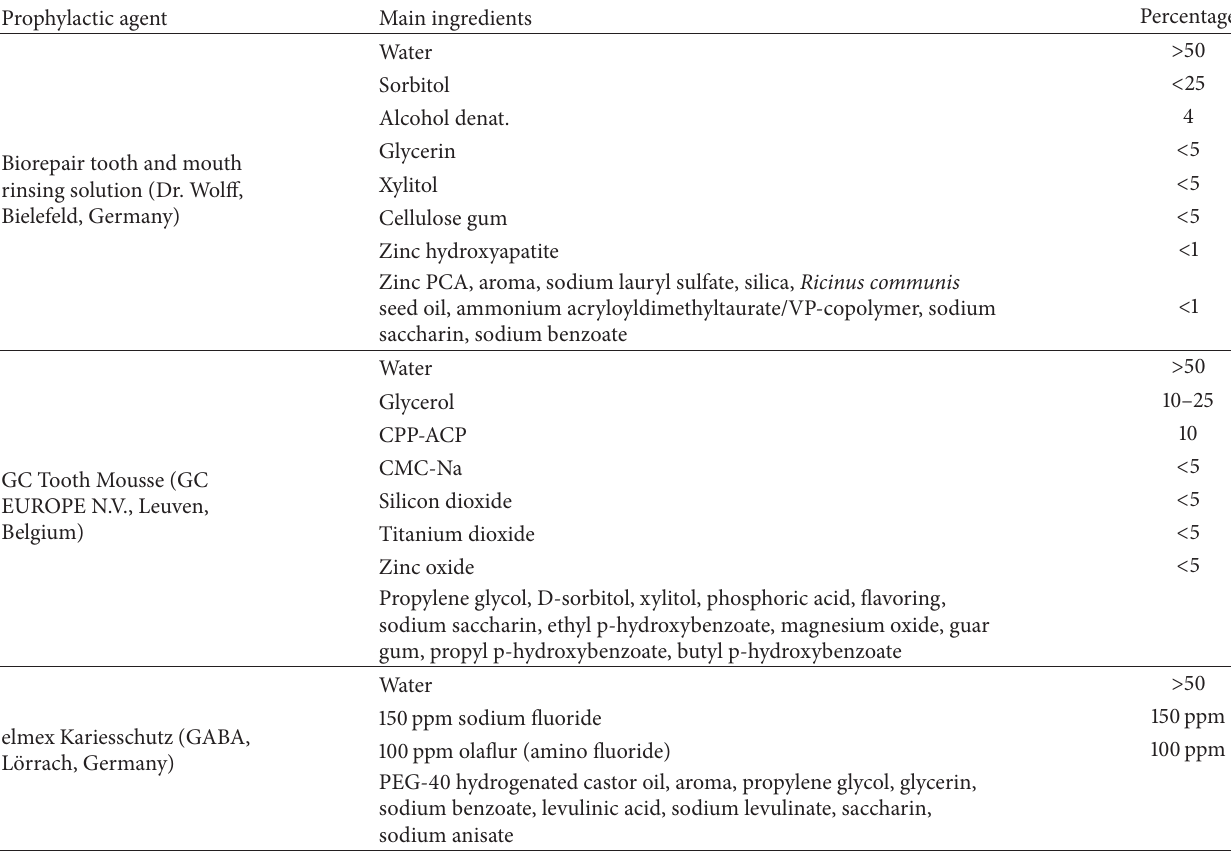
Table 1: Principle composition of prophylactic agents used in this